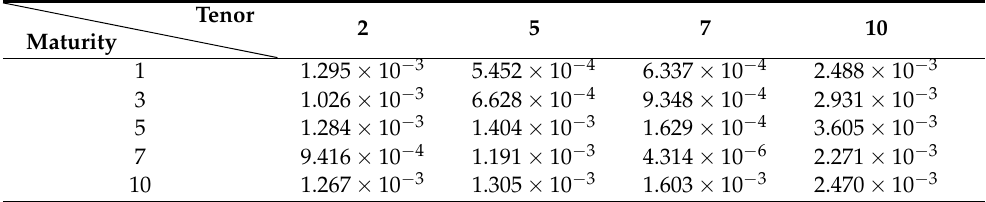
Table 6. Absolute errors of Monte-Carlo Bermudan payer swaption prices and Bloomberg’s HW1 Bermudan swaption prices using the I 1 as initial points for fmincon calibrated to the column with tenor equal to